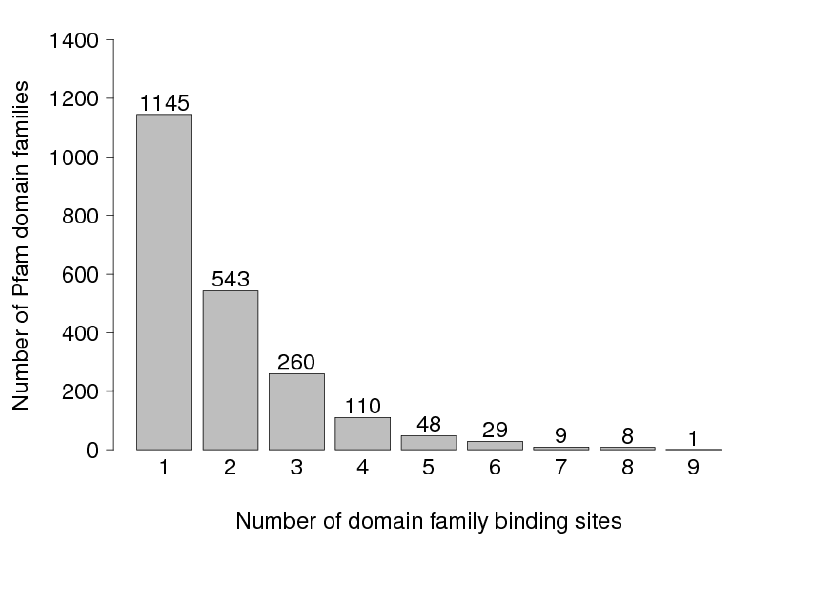
Figure 4. The distribution of Pfam domains depending on their number of DFBSs per domain.